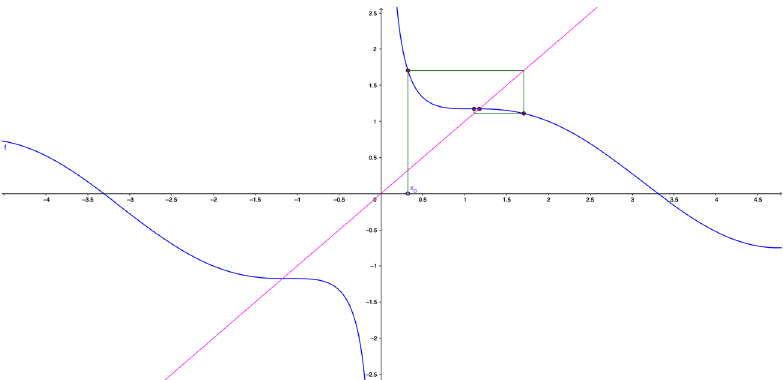
, the orbit of ζ − is 1 3 =